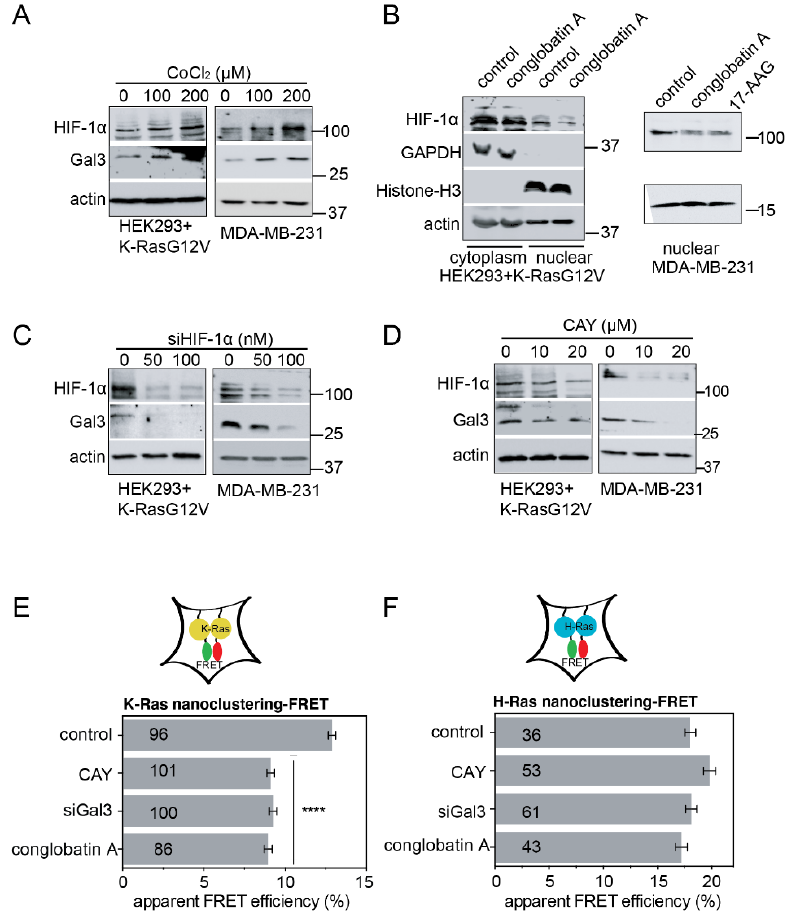
Figure 4. Conglobatin A depletes Hsp90 client HIF-1 α and its transcriptional target galectin-3. ( A ) Western blots of HEK cells transfected with mGFP-K-RasG12V, and of MDA-MB-231 cells treated for 16 h with CoCl 2 ; n = 1 independent biological repeat. ( B ) Western blots of cytoplasmic and nuclear extracts from HEK cells transfected with mGFP-K-RasG12V, and of MDA-MB-231 cells treated with either 0.1% DMSO vehicle control, 5 µ M, or 10 µ M conglobatin A, respectively. In total, 2 µ M 17-AAG served as the positive control. All of the drug treatments were for 24 h; n = 1 independent biological repeat. ( C ) Western blots of HEK cells transfected with mGFP-K-RasG12V, and of MDA-MB-231 cells 48 h after the siRNA-mediated knockdown of HIF-1 α ; n = 2 for HEK and n = 1 for MDA-MB-231 independent biological repeats. ( D ) Western blots of HEK transfected with mGFP-K-RasG12V, and of MDA-MB-231 cells treated with 0.1% DMSO vehicle control or HIF-1 α inhibitor CAY10585 (CAY) for 24 h; n = 1 independent biological repeat. ( E , F ) K-RasG12V- ( E ) and HRasG12V- ( F ) nanoclustering-FRET in HEK cells co-transfected with mGFP- and mCherry-tagged RasG12V, together with 50 nM siRNA-Gal3 or 50 nM scrambled siRNA for the compound/vehicle (control) treated samples. The next day, the cells were treated for 24 h with 0.1% DMSO, 2 µ M conglobatin A, or 10 µ M CAY10585 (CAY). The numbers in the bars indicate the number of analyzed cells. The number of independent biological repeats n = 2 for K-Ras and n = 1 for H-Ras. **** p < 0.0001.